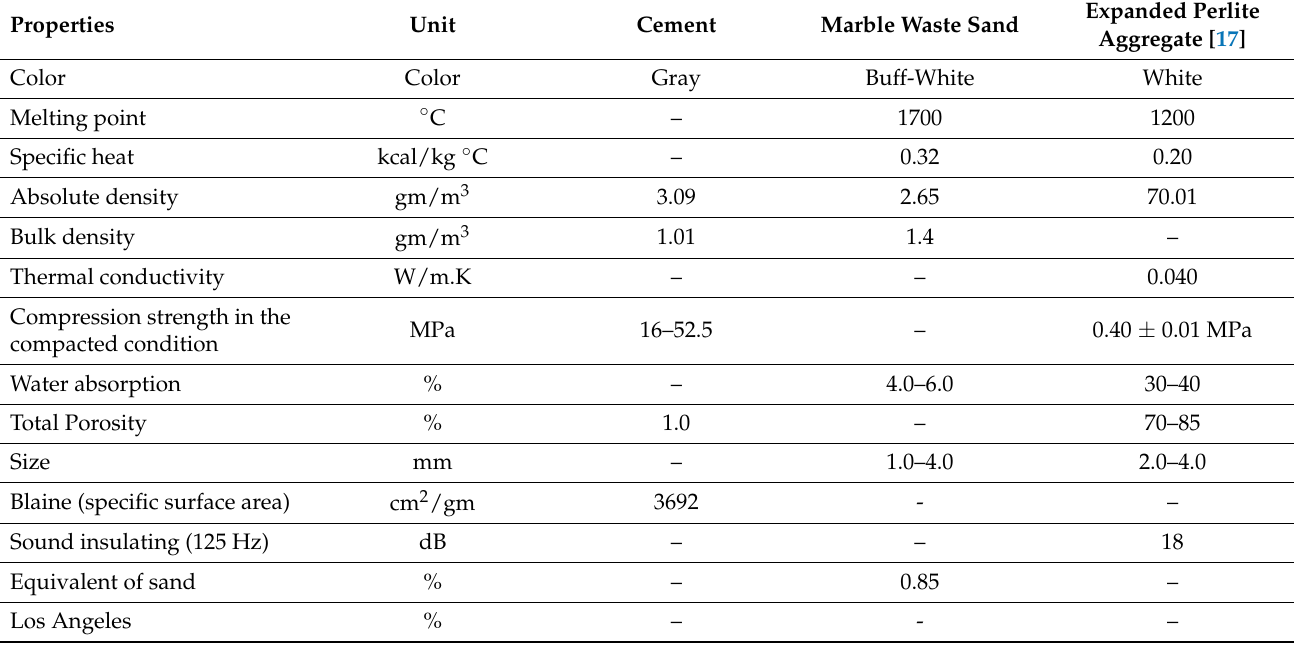
Table 1. Physical and mechanical properties of